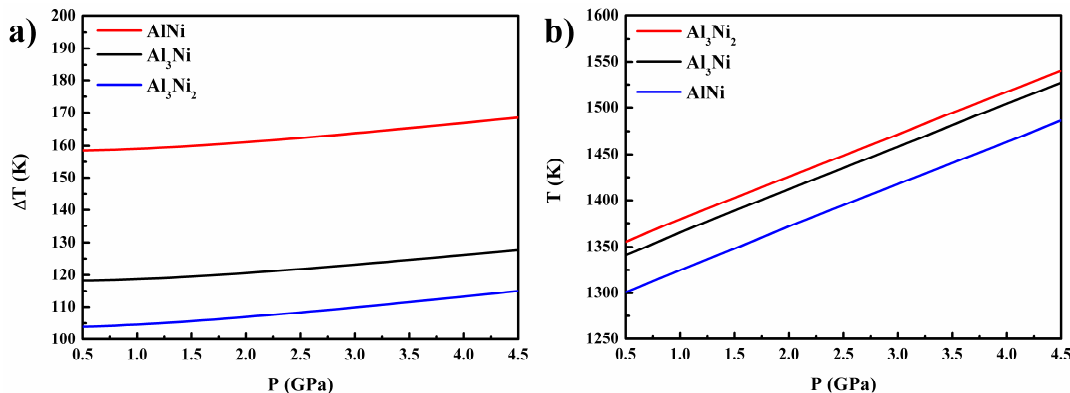
Figure 4. ( a ) The effect of high pressure on the interfacial undercooling of AlNi, Al 3 Ni 2 and Al 3 Ni phase. ( b ) The effect of high pressure on the interfacial temperature of AlNi, Al 3 Ni 2 and Al 3 Ni